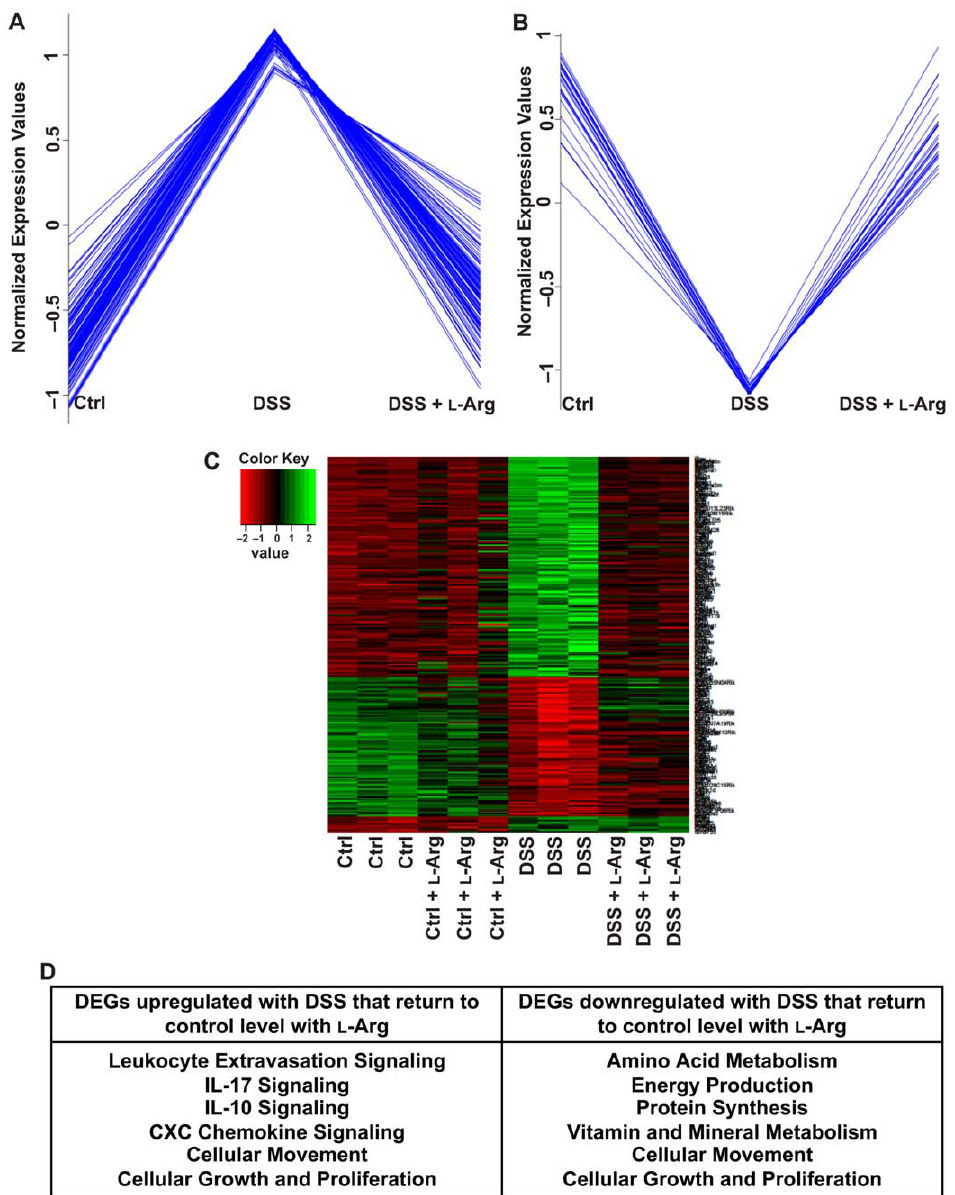
Figure 8. Multiple pathways altered after exposure to DSS return to baseline with L-Arg supplementation. Pathway analysis based on DEGs. (A) 132 genes were found to be upregulated in response to DSS that were subsequently downregulated to control levels after L-Arg supplementation. (B) 27 genes were downregulated in response to DSS and returned to control levels after L-Arg supplementation. (C) Heatmap of the DEGs based on the expression pattern of increased expression after exposure to DSS and decreased expression following L-Arg supplementation. (D) Table showing examples of biologic and signaling pathways, derived from Ingenuity Pathway Analysis, that were found to be affected by these altered gene expression patterns.